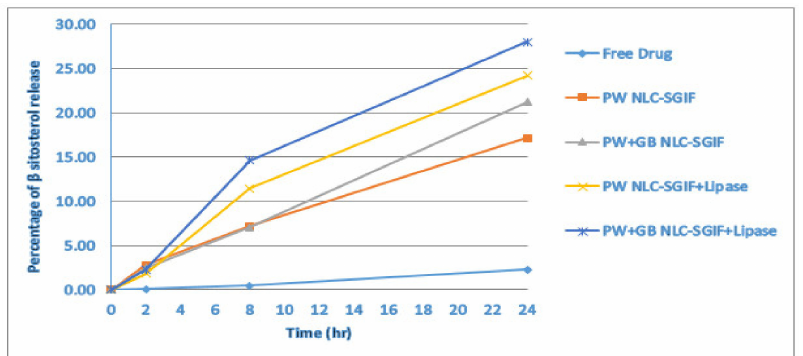
Figure 7. In vitro release profiles of the β -sitosterol-loaded NLCs in the simulated gastro-intestinal fluid (SGIF) with or without a lipase in comparison with a free drug suspension. PW and PW + GB represent the NLCs formulated with propolis wax alone or its binary mixture with glyceryl behenate (1:1),